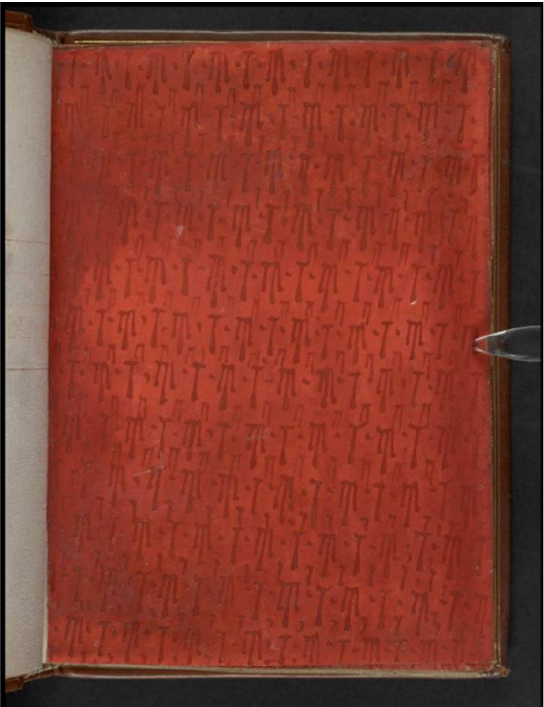
Figure 2. The manuscript has eight (originally ten) pages covered in red paint, hundreds of wounds and drops of blood. MS Egerton 1821, fol. 6r. British Library, London.